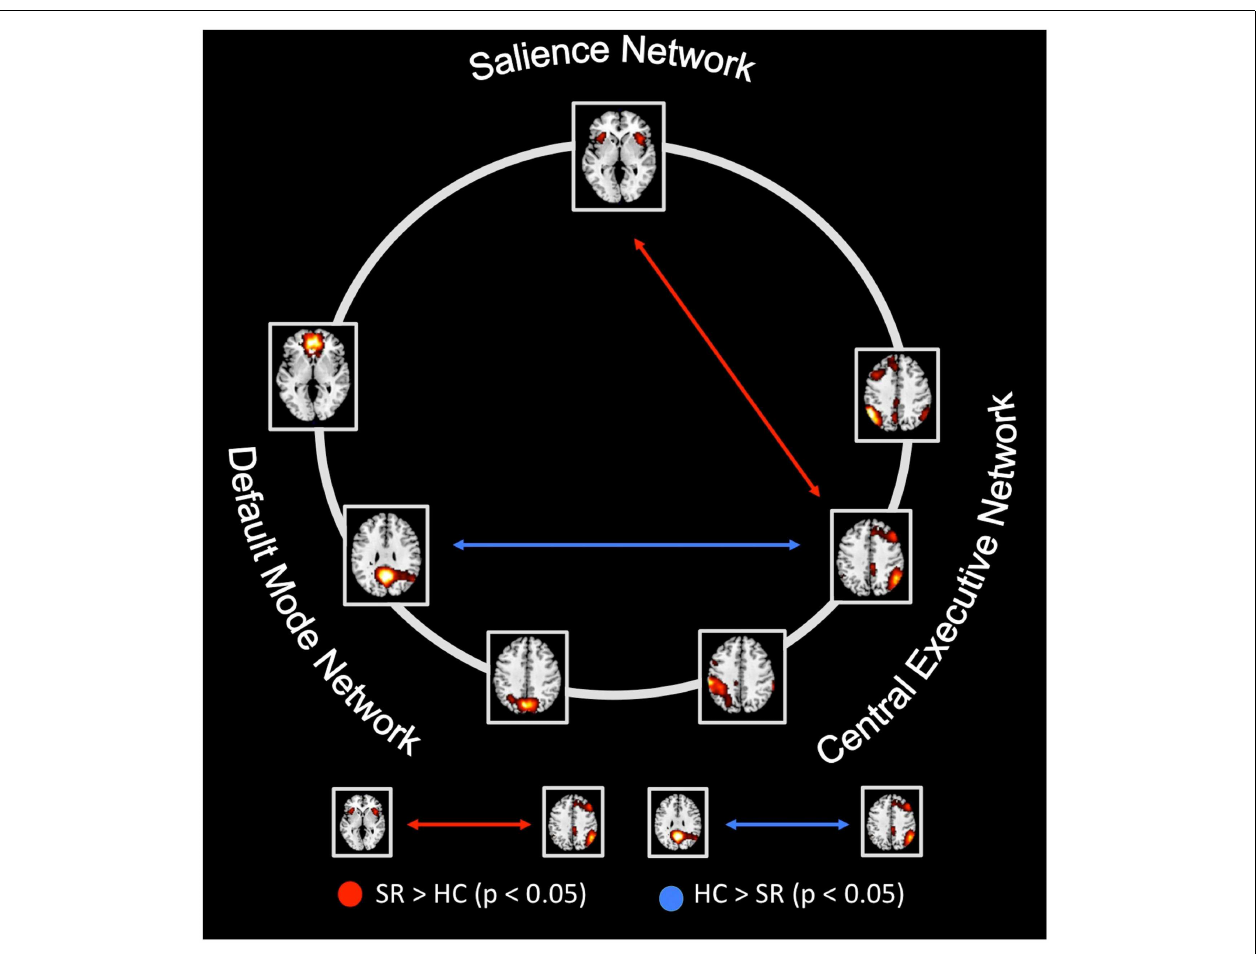
compared to HCs (two-sample t -test, p < 0.05, Bonferroni-corrected for multiple comparisons). Spatial maps indicate the anterior/inferior- posterior/superior-posterior default mode network (a/ip/spDMN), left-ventral/right-ventral/dorsal central executive network (lv/rv/dCEN), and salience network (SN). All tests were corrected for age, sex and total GM volume. Abbreviations: SR, group of patients with schizophrenia during remission; HC, healthy control group (see also Table 5